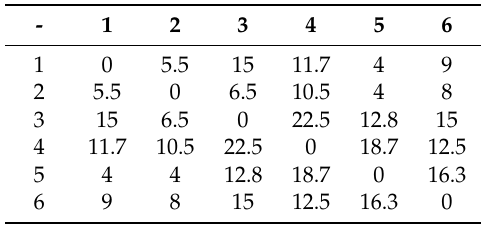
Table 9. The distance (km) from field to field.